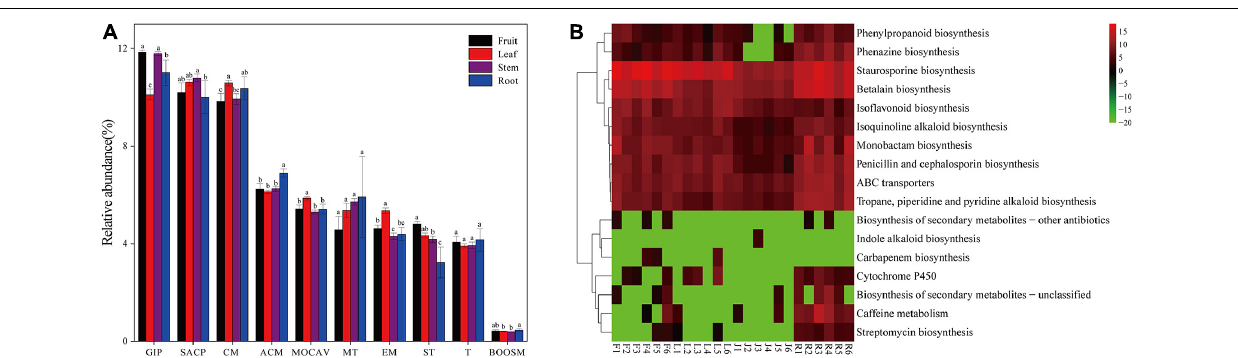
FIGURE 5 | (A) Gene functional predictions of endophytic microbiota between different plant compartments. (GIP: genetic information processing; SACP: signaling and cellular processes; CM: Carbohydrate metabolism; ACM: Amino acid metabolism; MOCAV: Metabolism of cofactors and vitamins; MT: Membrane transport; EM: Energy metabolism; ST: Signal transduction; T: Translation; BOOSM: Biosynthesis of other secondary metabolites). (B) Comparisons of the seventeen gene pathways involved in the biosynthesis of secondary metabolites in the bacterial microbiota. Values of each functional gene (row) were log2 transformed. The